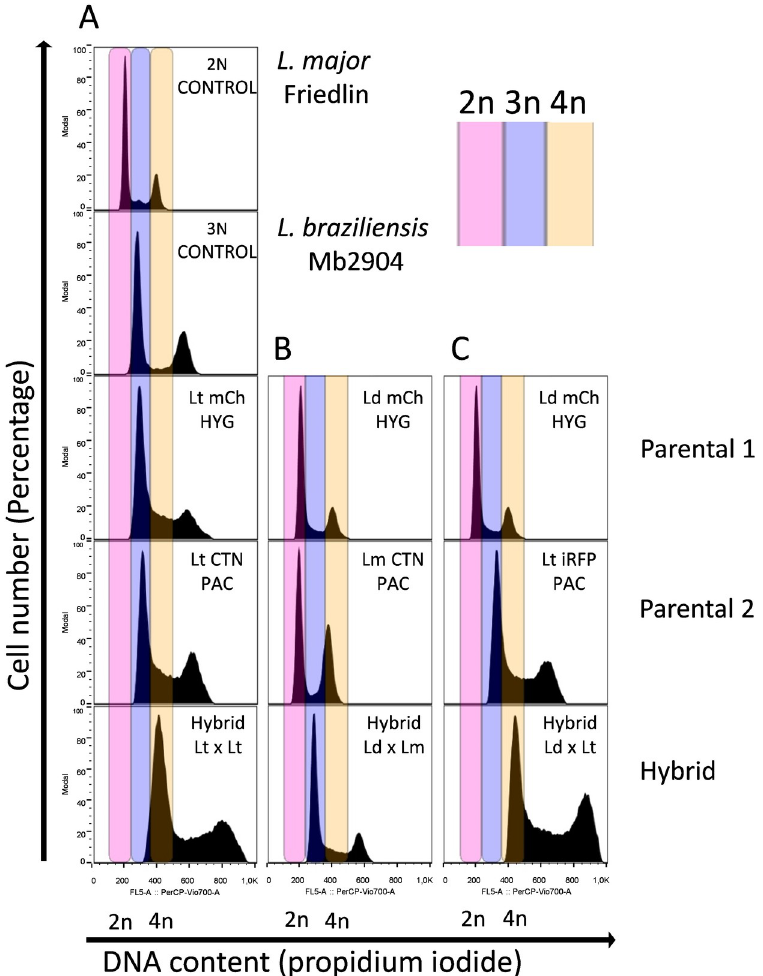
Fig 4. Analysis of the ploidy profile. (A) Representative chart of flow cytometry showing the ploidy of L . tropica mCh HYG (Lt mCh HYG), L . tropica CTN PAC (Lt CTN PAC) and one hybrid of the intraclonal crossing (Hybrid 1 Lt x Lt). (B) Representative chart of flow cytometry showing the ploidy of L . donovani mCh HYG (Ld mCh HYG), L . major CTN PAC (Lm CTN PAC) and one hybrid of the interspecies crossing (Hybrid 1 Ld x Lm). (C) Representative chart